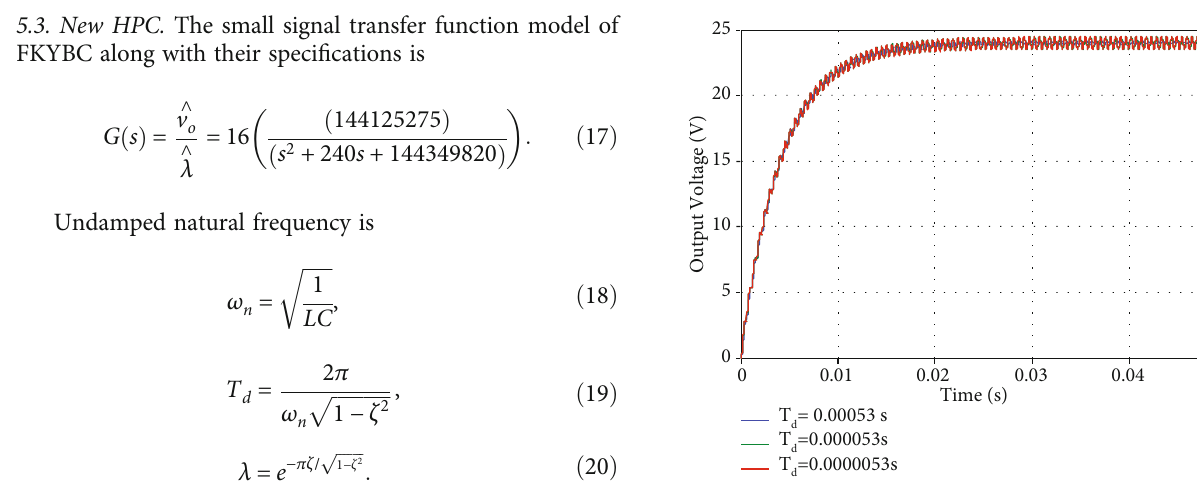
of FKYBC for unalike load R (a) with HPC and (b) with PID control. o